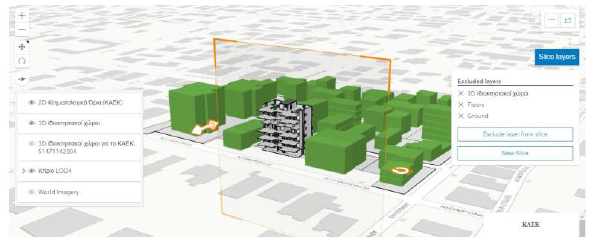
Figure 7. Results of using ‘Slice tool’ at the four-floor building.